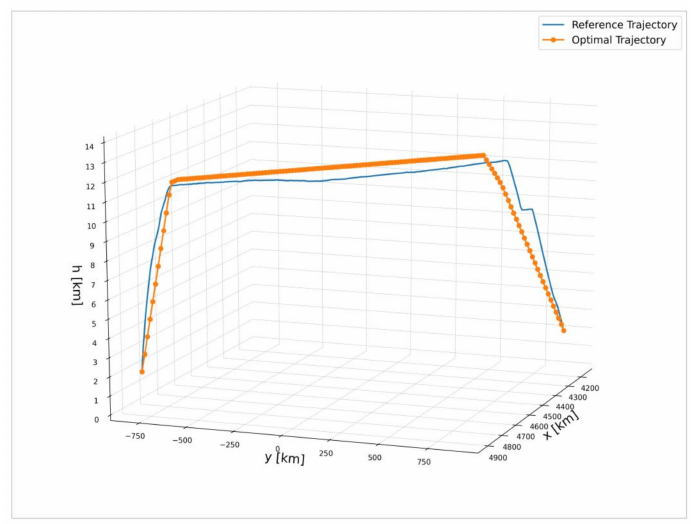
Figure 6. Comparison of reference and emissions-optimal 3D